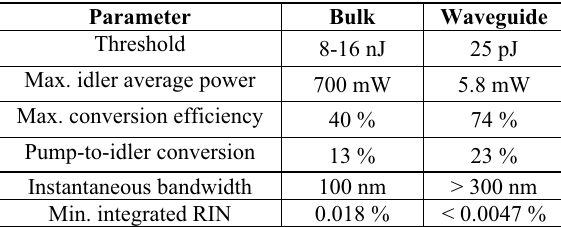
Table 1. Comparison of bulk and waveguide systems. Parameter Bulk Waveguide